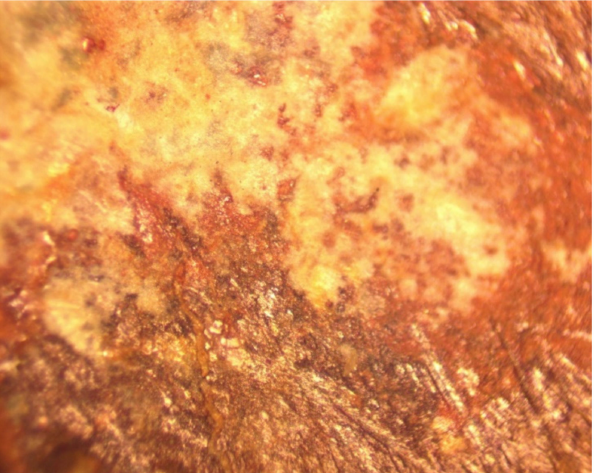
Figure 10. Simplified electrochemical model showing how the Fe-polymers transport Na + and Cl − ions from the water body into dead-end pores. The β * notation indicates that the polymer has an oxidation number and ion charge, which can vary in response to changing environmental conditions.